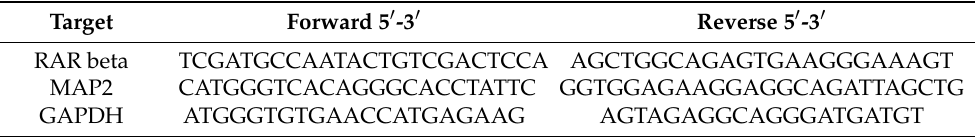
Table 1. Primers used to monitor SH-SY5Y differentiation by